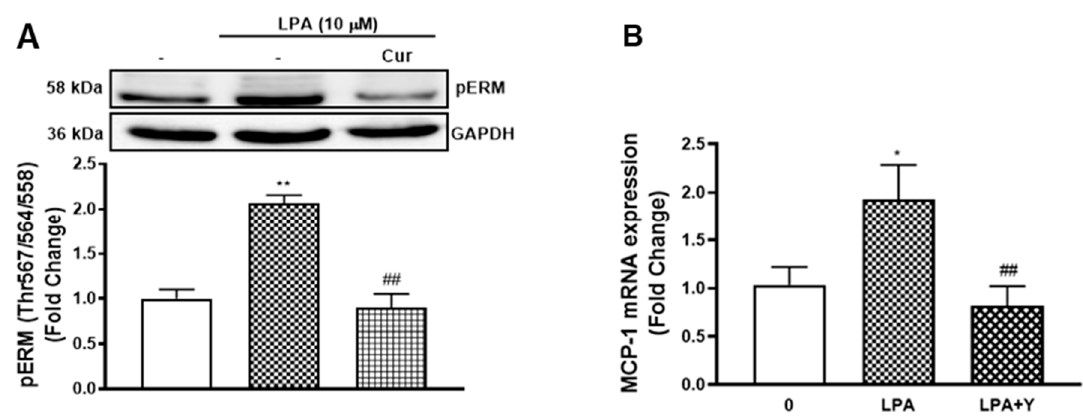
Figure 6. Curcumin inhibits LPA initiated MCP-1 expression via blocking ROCK signalling. ( A ) VSMCs were pre-incubated with 10 µ M curcumin for 30 min before treatment of LPA (10 µ M) for 15 min. Blots were probed with primary antibodies specific to phospho-Ezrin (Thr567)/Radixin (Thr567)/Moesin (Thr558) (1:2000) and secondary HRP conjugated rabbit IgG antibody (1:2000). Blots are representative of three independent experiments. ( B ) VSMCs were pre-incubated with 10 µ M Y27632 for 30 min before treatment with LPA (10 µ M) for 2 h. Total RNA was harvested and assessed by qRT-PCR. 18S was used as a house keeping gene. Results are expressed as mean ± SEM from three independent experiments. Statistical significance was determined by one-way ANOVA, followed by least significant difference post-hoc analysis. * p < 0.05 and ** p < 0.01 versus basal; ## p < 0.01 versus LPA only treated sample.